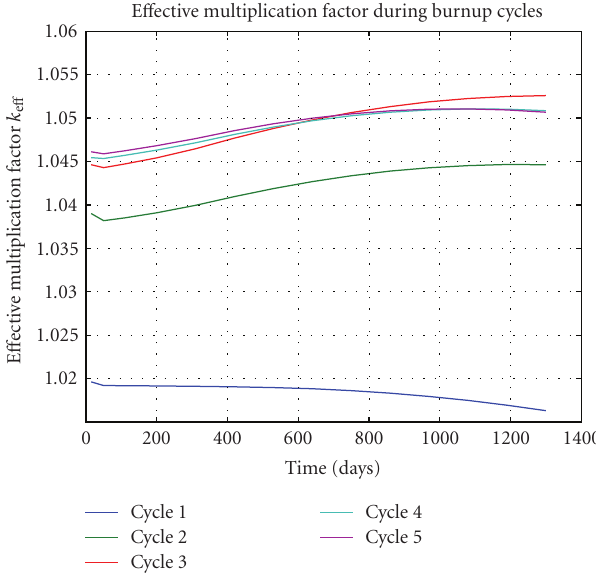
Figure 7: Succesive irradiation campaigns, changing the MA- fraction added in reprocessing to achieve k e ff ,final = 1 . 05, starting from a 0% MA fuel. From the third cycle, the objective is met.